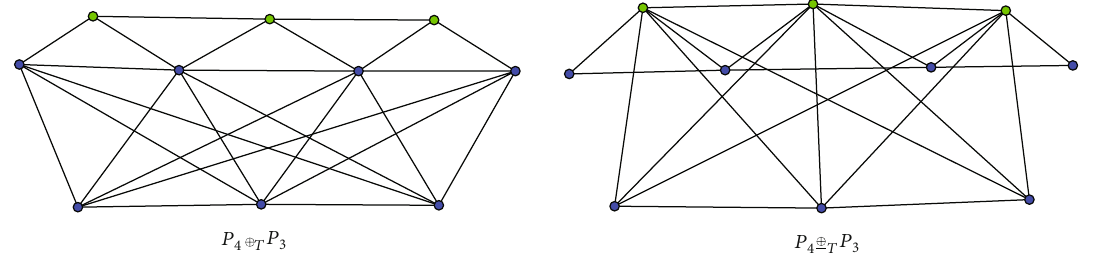
Figure 5: The VTG and ETG of P